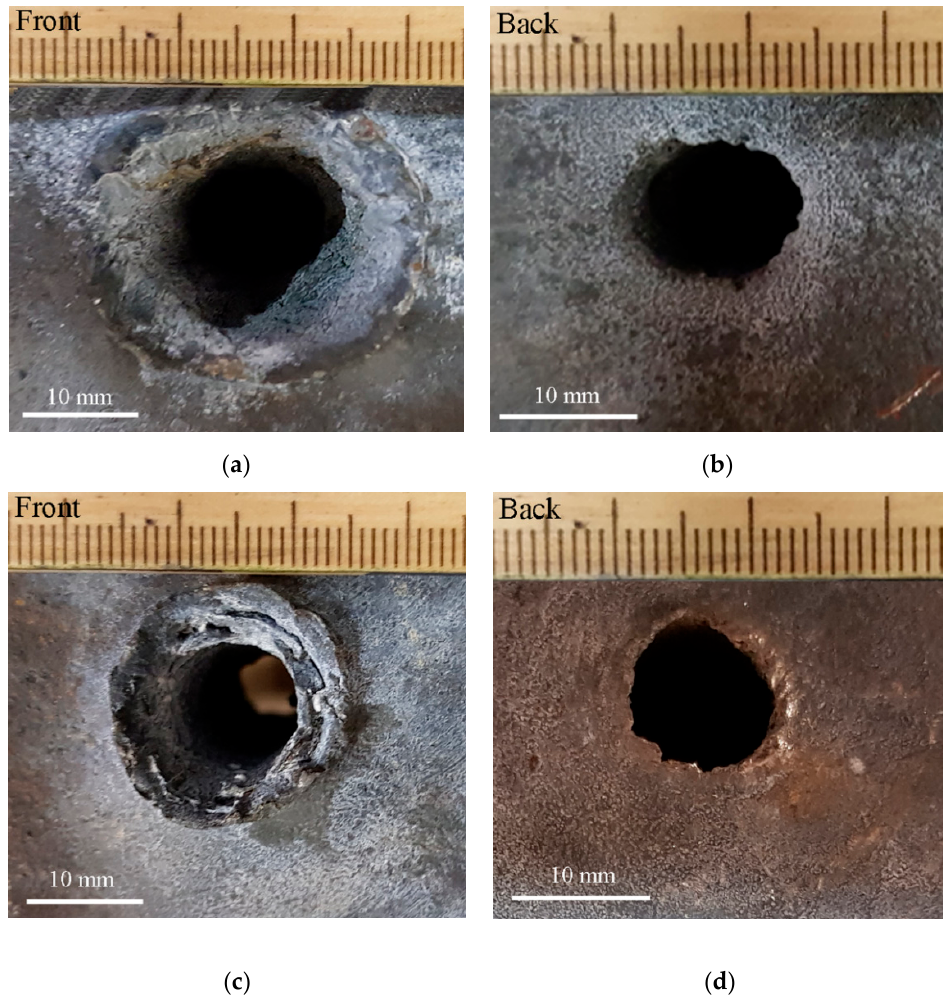
Figure 6. Examples of results of the entry and the exit openings after a shot with a ŁK type shaped charge: ( a ) hole of axial charge entrance; ( b ) hole of axial charge exit; ( c ) hole of peripheral charge entrance; ( d ) hole of peripheral charge exit. Table 2. A list of the diameters of the entrance and exit holes from a shaped